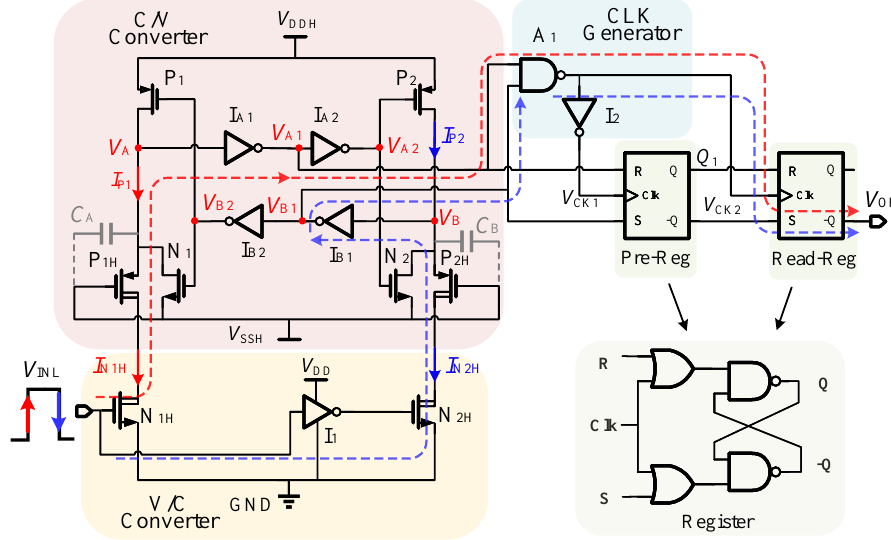
Figure 3. Implementation of the proposed FHV-LS.